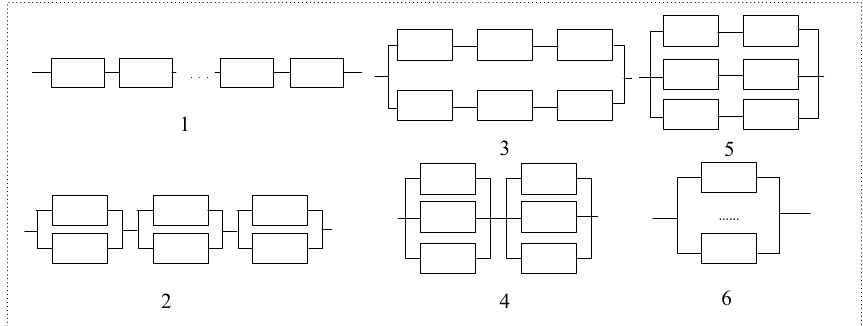
Table 3. Statistical distribution of cell parameters.